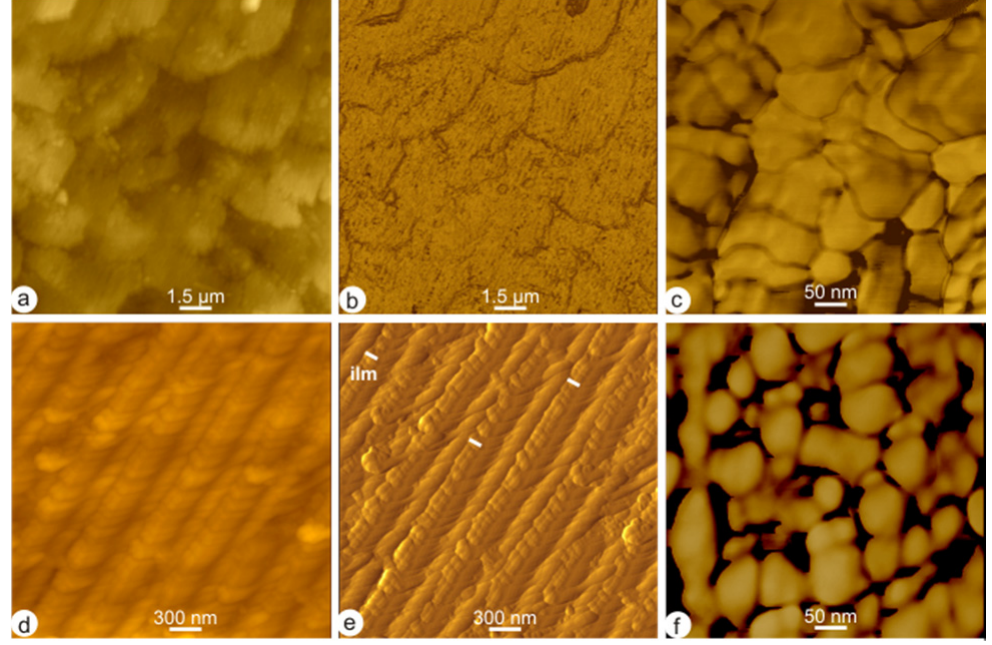
Figure 2. Nanostructure of the shell of Pinctada margaritifera. Inner surface of the shell, showing the partially superimposed tablets. Muvei’s solution 10 min, room